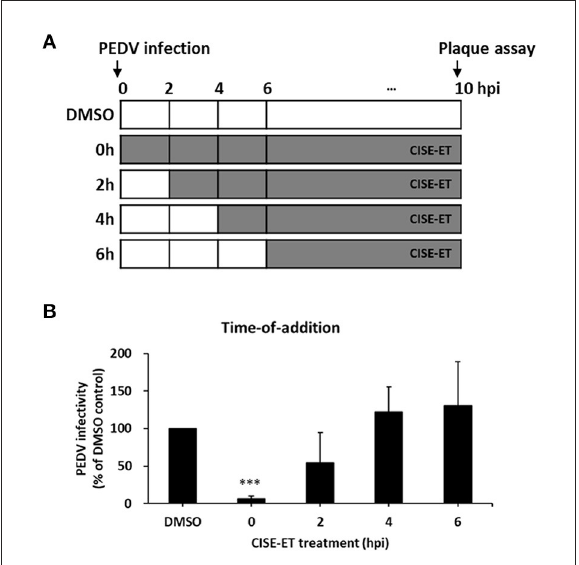
FIGURE3 CISE-ET inhibited the early phase of PEDV infection. (A) Schematic of the time-of-addition experiments. Vero cells were infected with PEDV (MOI = 1), and 30 µ g/ml CISE-ET was added at the indicated time points after virus infection. At 10 hpi, the virus titers were measured by plaque assay. (B) The viral infectivity is expressed relative to that obtained for the DMSO control group. The error bars represent the SDs from the means ( n = 3). *** P <